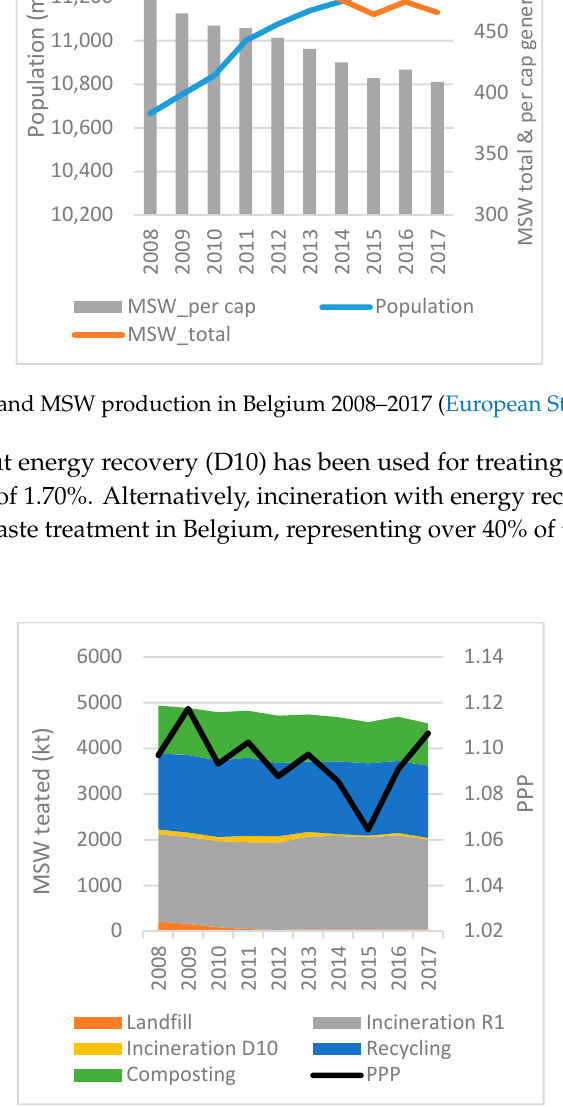
Figure 2. Waste treatment methods and PPP in Belgium 2008–2017 (EUROSTAT 2019b, 2019c).